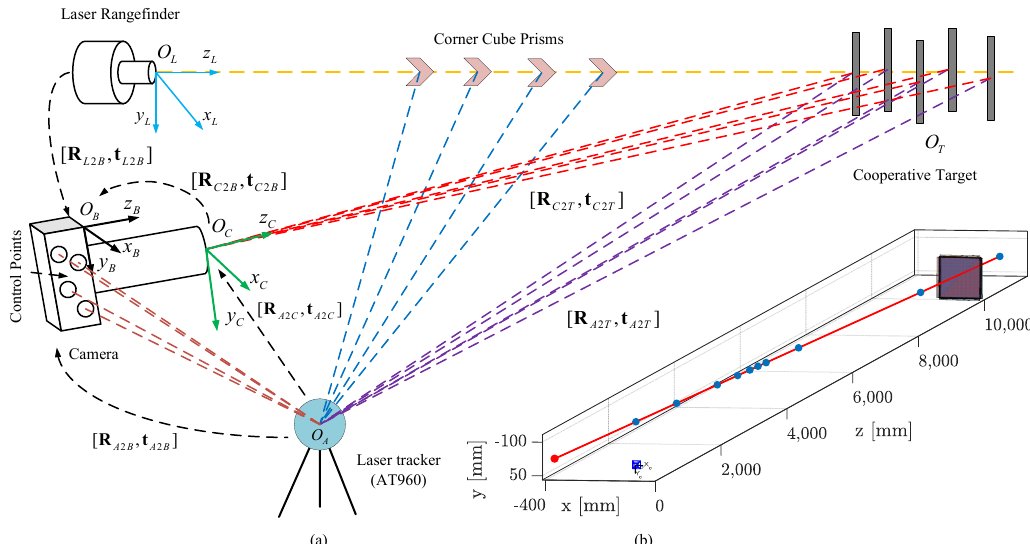
Figure 3. Illustration of the proposed calibration method: ( a ) design of the proposed calibration procedure; ( b ) diagram of the calibration